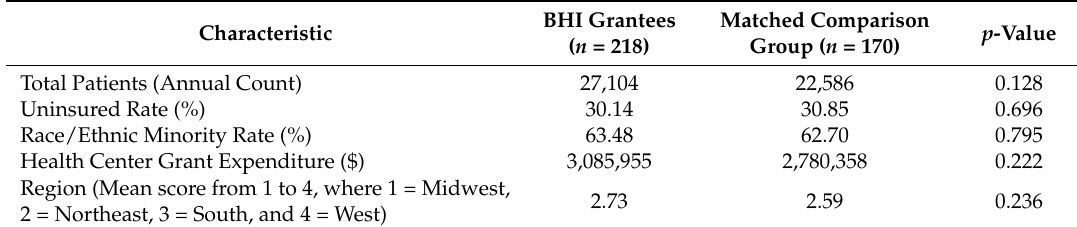
Table 2. Summary Statistics: BHI Grantees vs. Propensity Score-Matched FQHC Comparison Group at